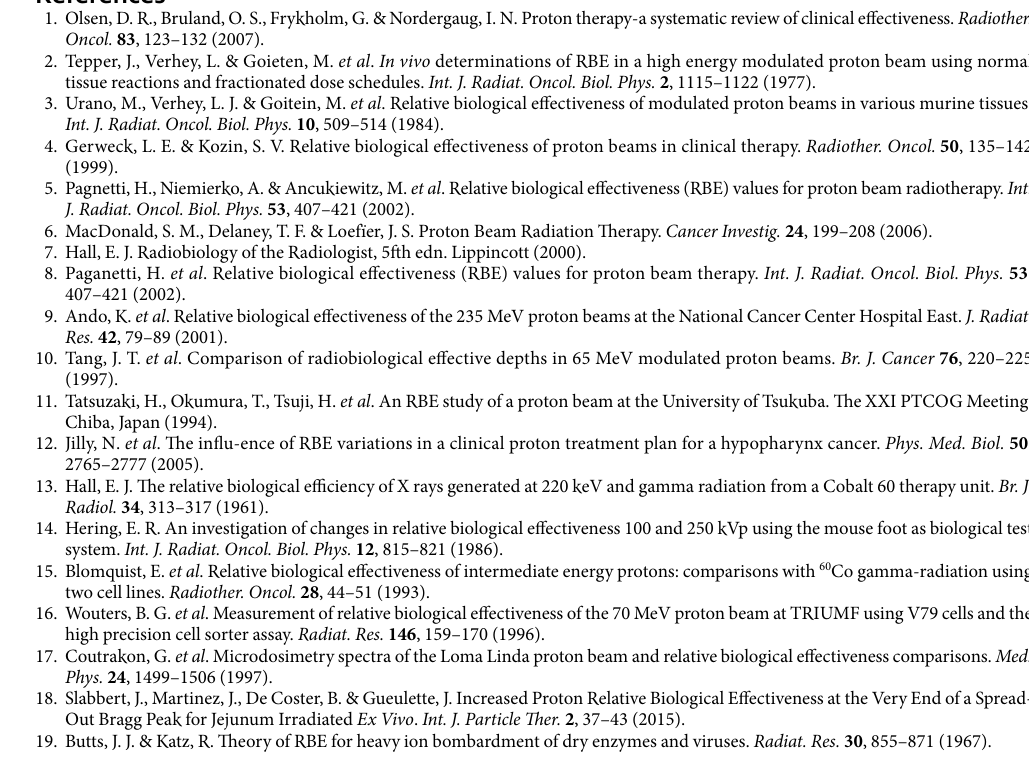
of the extracted parameters α and β of the linear quadratic model due to uncertainties in the biological data are considerably reduced. To demonstrate the reduction in numerical noise, we provided a comparison between traditional methods of post-processing of the clonogenic survival data and our approach. The numerical fluctuations in RBE parameters seen when an independent fitting of cell survival data is performed, can be suppressed by integrating the LET models including gMKM, LEM, and MCDS-RMF into 3D global fitting. The latter based on gMKM predicts a gradual increase in, α , β , and α / β as a function of LET, consistent qualitatively with the cell-inactivation target theory. Further studies are on the way to implement other models such as multi-scale modeling 53, 54 as well as MCDS-RMF into 3D global fitting of the current clonogenic survival data (that non-linear LET terms in α and β can be interpreted as higher order and more complex chromosome aberrations) as well as convolving the spectrum of lineal-energies, d ε / dl , calculated by MC on α and β to take into account the effect of non-Poisson distribution. The latter is closely related to the ideas and approaches presented by Hawkins 29 and Kase et al . 55 and other studies presented in refs 56–60.